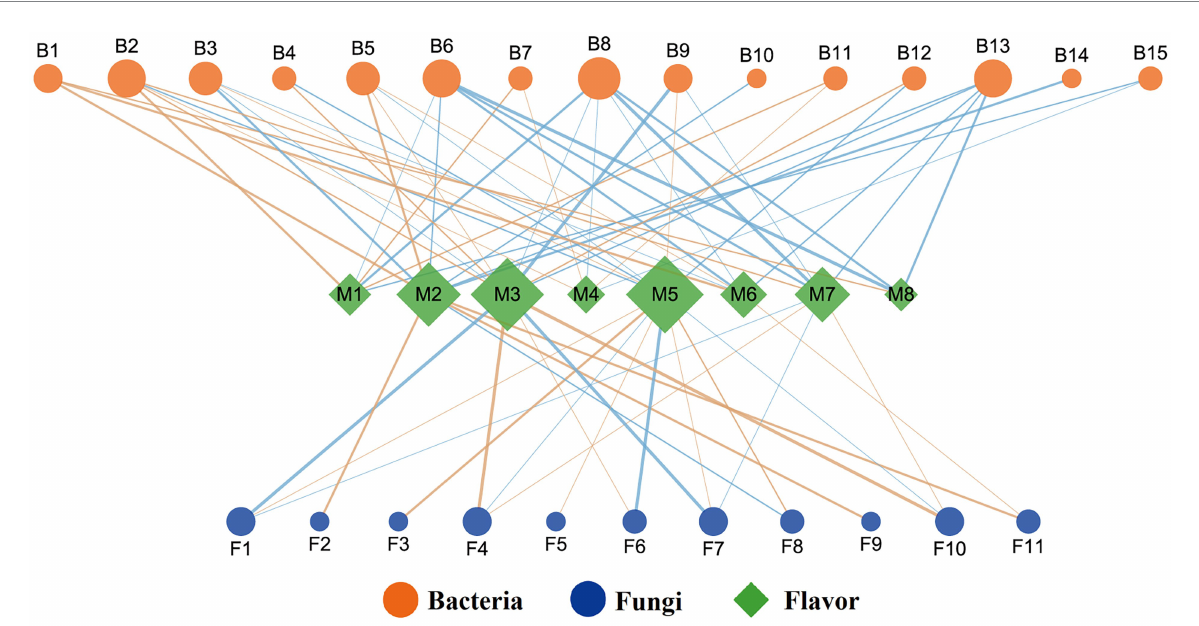
FIGURE 5 Spearman correlation analysis between dominant differential (LEfSe, LDA > 3) microorganisms and characteristic substance (VIP > 1). The brown edge represents positive correlation, the blue edge represents negative correlation, and the thickness of the edge represents the degree of correlation, the thicker the edge, the stronger the correlation. The size of the node represents the number of objects related to it, the larger the node, the more objects associated with